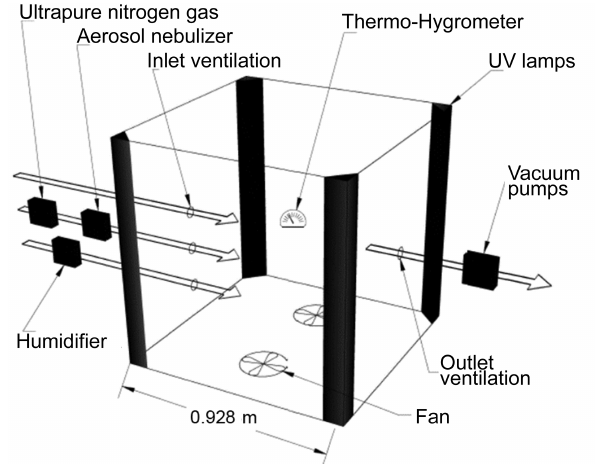
Figure 1. Schematic of bioaerosol test chamber. In independent tri- als, dry ultrapure nitrogen aerosolized and diluted different pure cultures of bacteria, fungi and pollens into a temperature (20 ◦ C)- and RH (25–40%)-controlled chamber (890L). Bioaerosol deliv- ery vessels were fitted with steel ports, and all gas streams were contained in 0.4cm conductive neoprene tubing, carrying 151kPa at a flow rate of 12Lmin − 1 into the